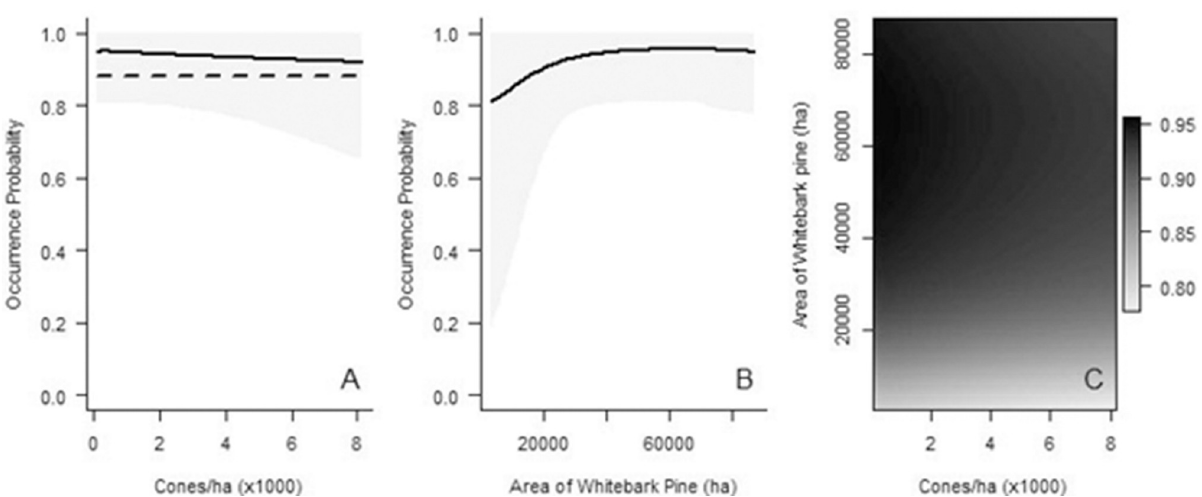
Fig 4. Predicted probability of Clark’s nutcracker occurrence during the late summer as a function of the (A) whitebark pine cones/ha, (B) area of whitebark pine on the landscape, and (C) both metrics. The graphs depict predictions based on data from infinite radius surveys. Values represent area of whitebark pine habitat within 32.6 km. On each graph, all variables in the models that are not shown on the graphs, are held at the mean. Gray shaded areas denote 95% Bayesian Credible Intervals. In A, the reference horizontal line shows the intercept when no cones are